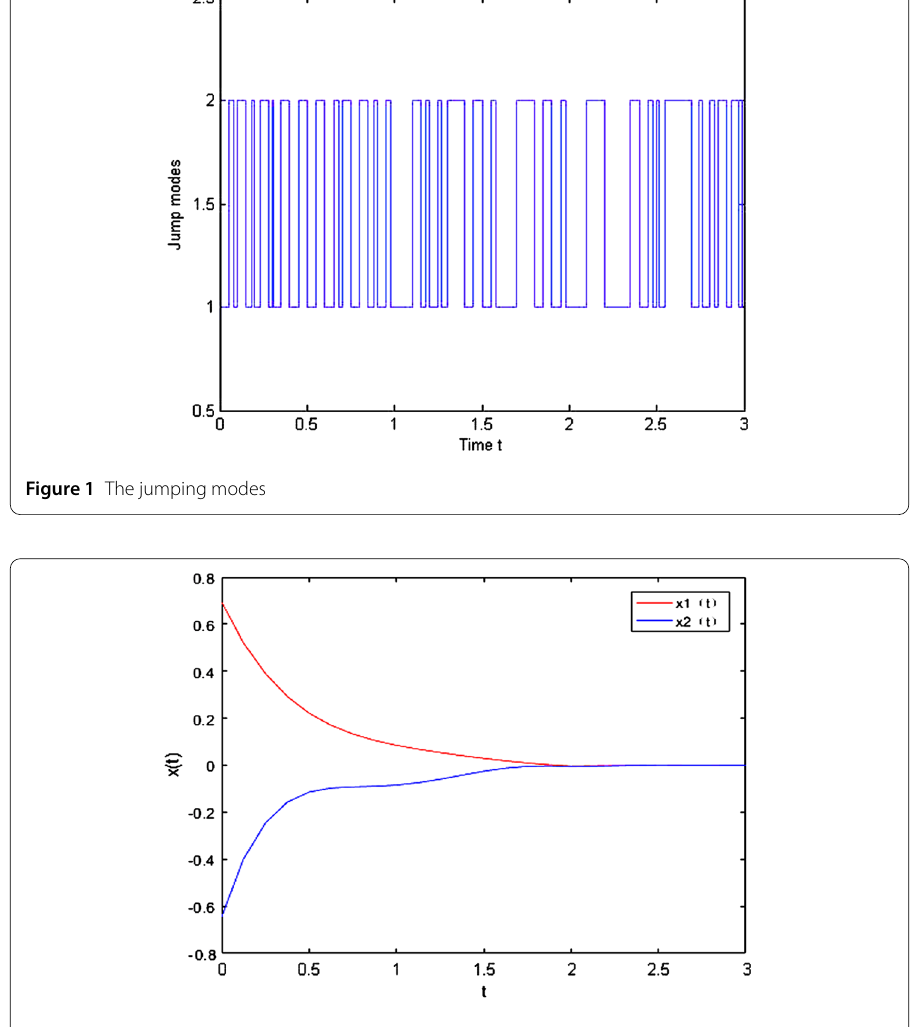
Figure 2 The trajectory of